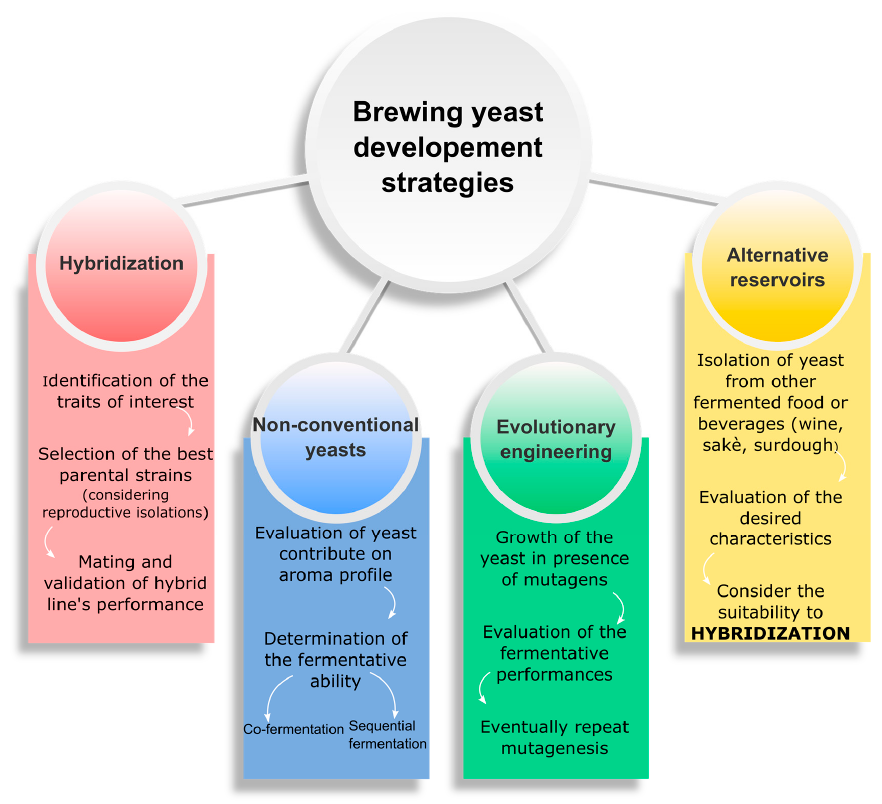
Figure 2. Main trends in brewing innovation. Knowledge on molecular mechanisms underpinning beer-relevant phenotypes drives the search for novel and personalized starter cultures by the application of non-genetic engineering techniques.